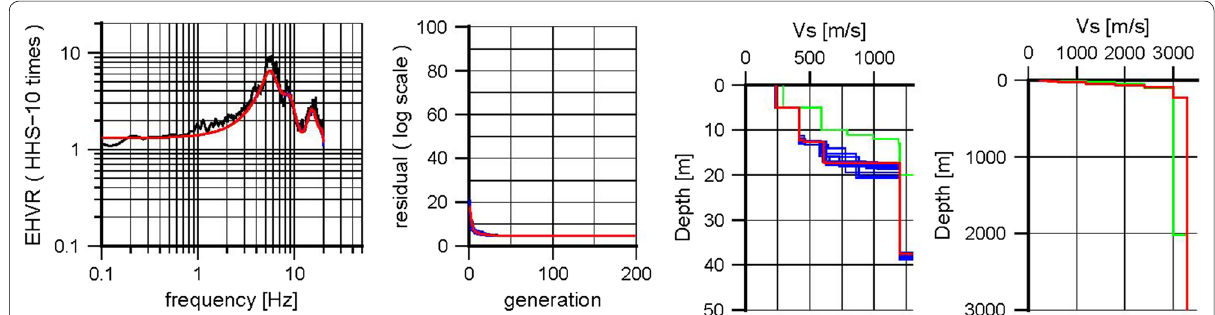
Fig. 6 Best-fit model (red line) in comparison with the observed EHVR (black line) in the left panel, convergence with respect to the generation in the middle panel, and shallow (< 50 m) and deep (< 3 km) part of the obtained S-wave velocities at a K-NET site, EHM012 in the two right panels. Green lines in the two right panels are S-wave velocities of the initial model, while blue lines are those for ten individual trials with different initial genes. The red line represents the best model among these ten trials